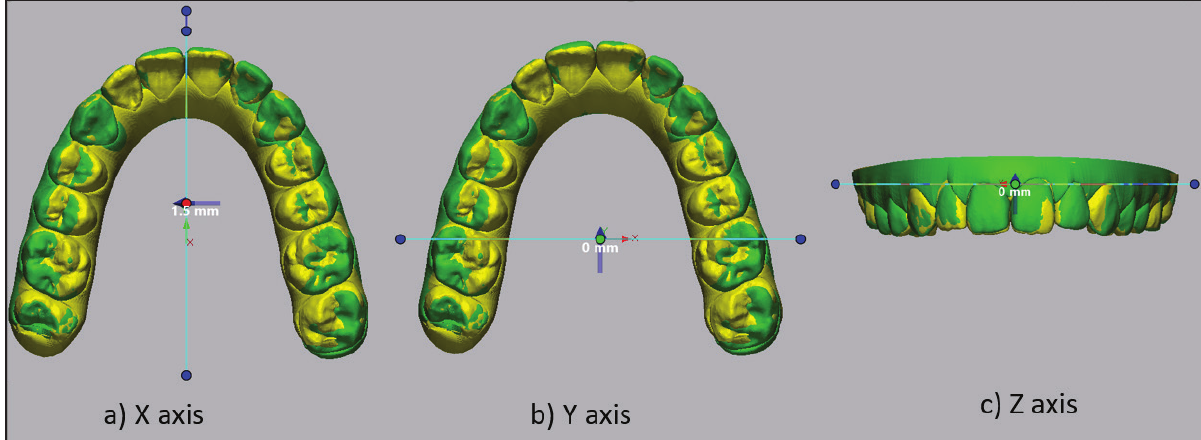
Figure 7. 2D slices for heat map superimposition in the three planes of space. NB, a slice can be made at any point or level through the model.